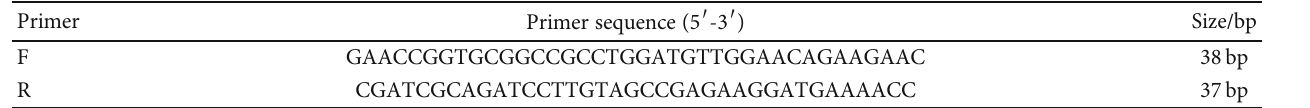
Table 1: pri-miR-302d primer sequences.